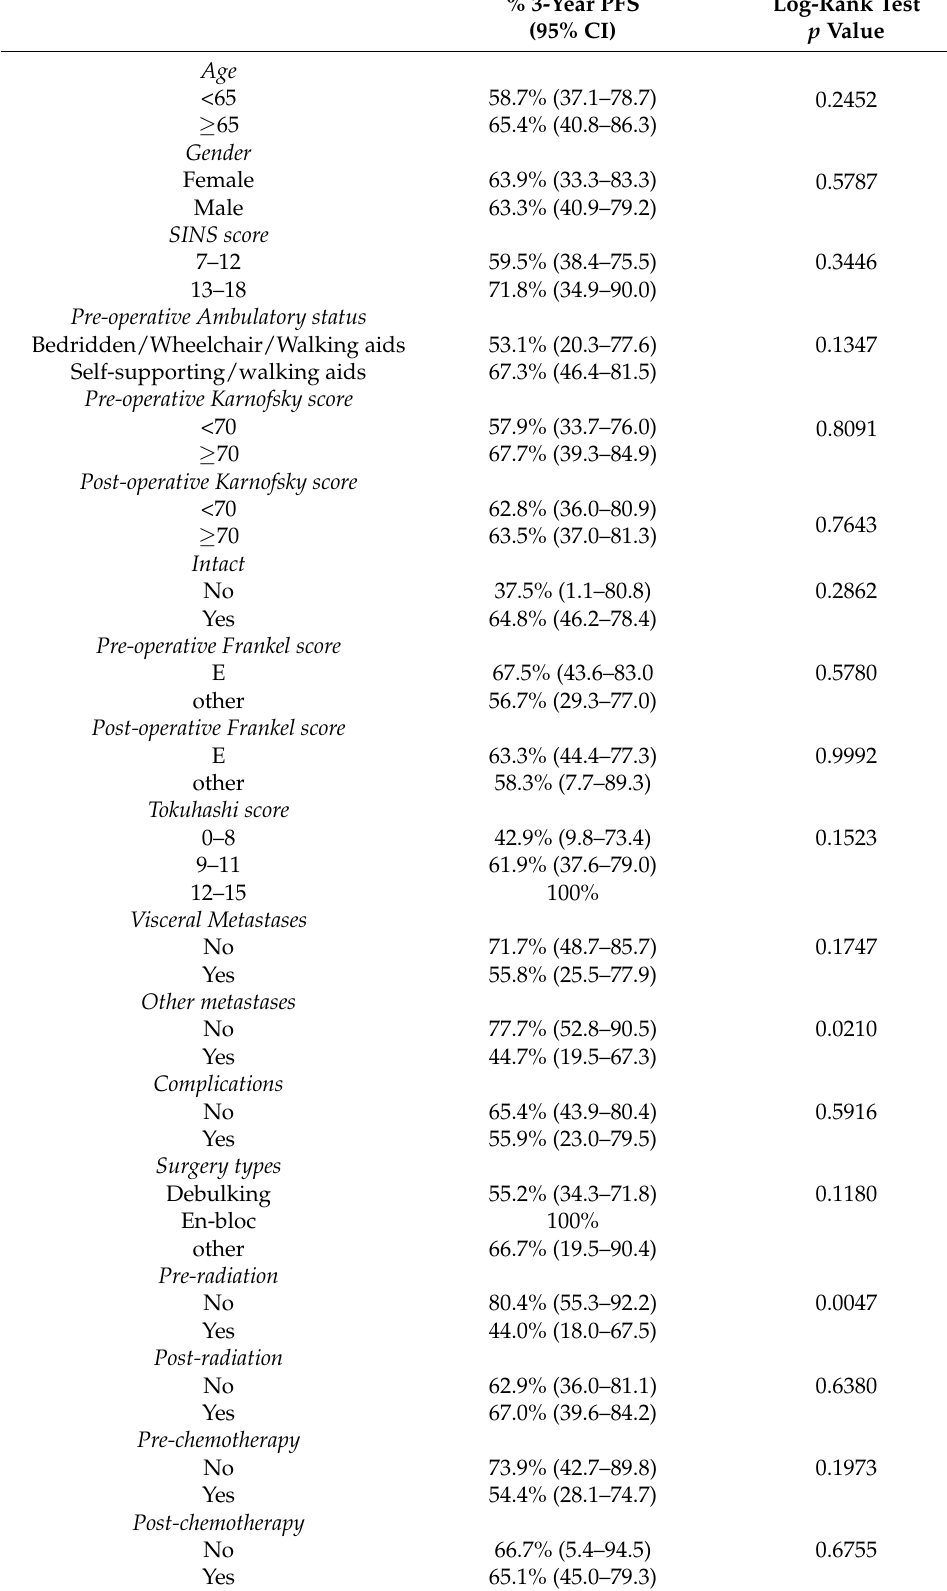
Table 6. Univariate analysis of the prognostic factors affecting 3-year progression-free survival